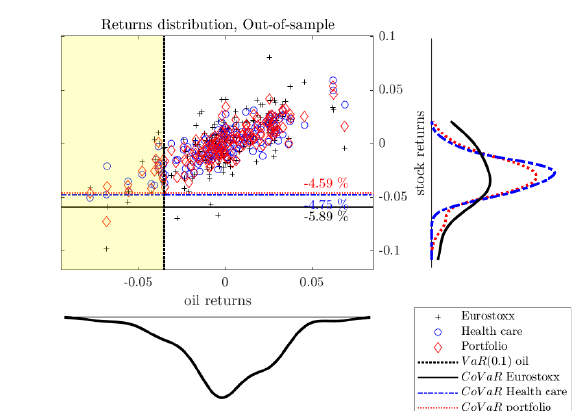
(a) Y-axis shows the conditional distribution for the stock portfo- lios given a downward movement in oil prices